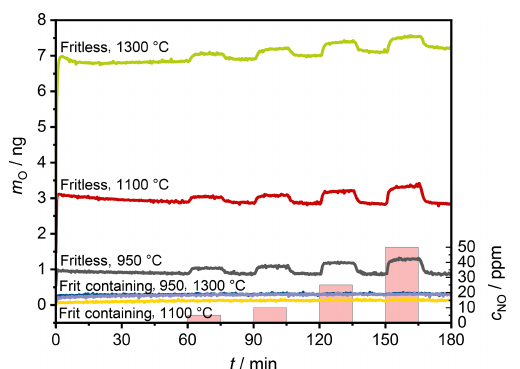
Figure 7. Pumped oxygen m O pumped during positive polarization pulses of